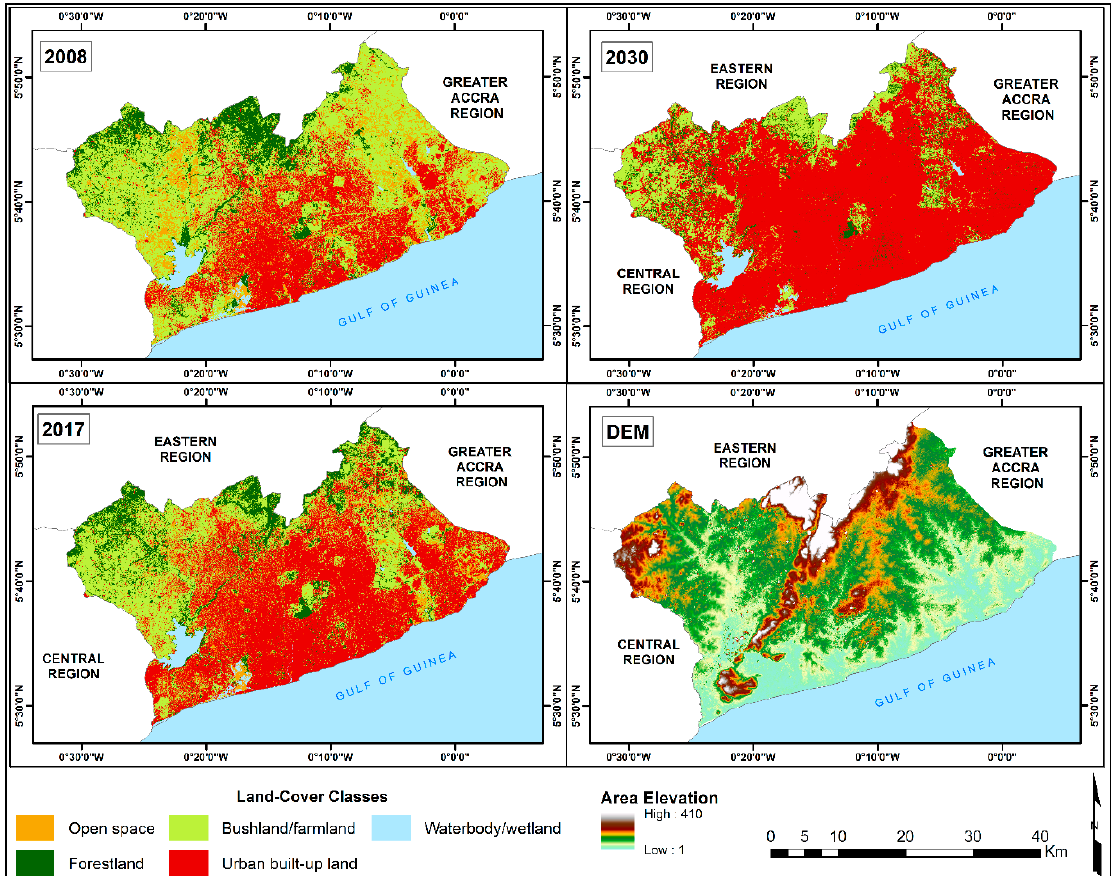
Figure 2. Actual land-cover maps for the years 2008 and 2017, predicted land-cover map for 2030 and elevation map of GAMA. Land 2020 , 9, x FOR PEER REVIEW